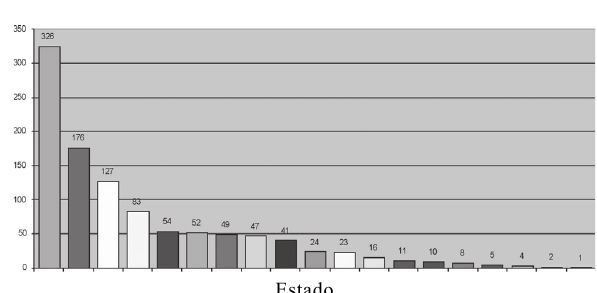
Estado Fig. 2 - Corações recebidos no BVCSH, estratificados por Estado